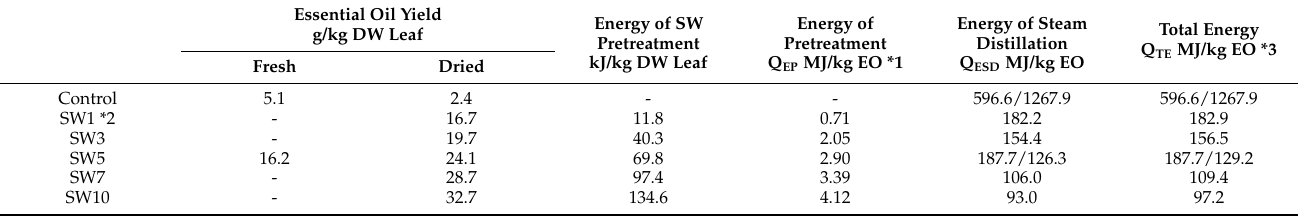
Table 1. Essential oil yield of A. sachalinensis by steam distillation with SW pretreatment; energies of SW pretreatment, pretreatment, steam distillation; and total energy.